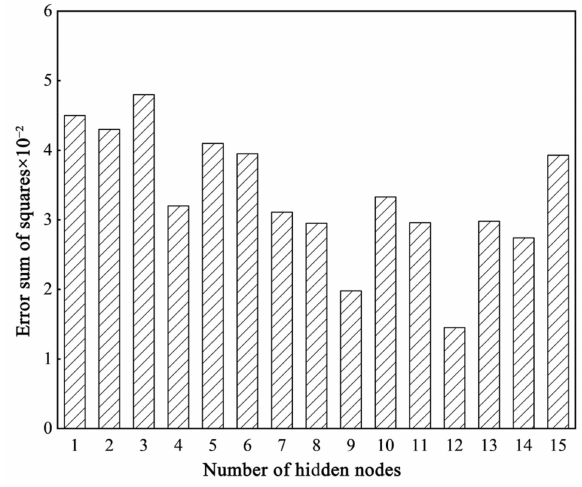
Figure 4. Sum squared error of BP neural network ( η ) in different hidden layer